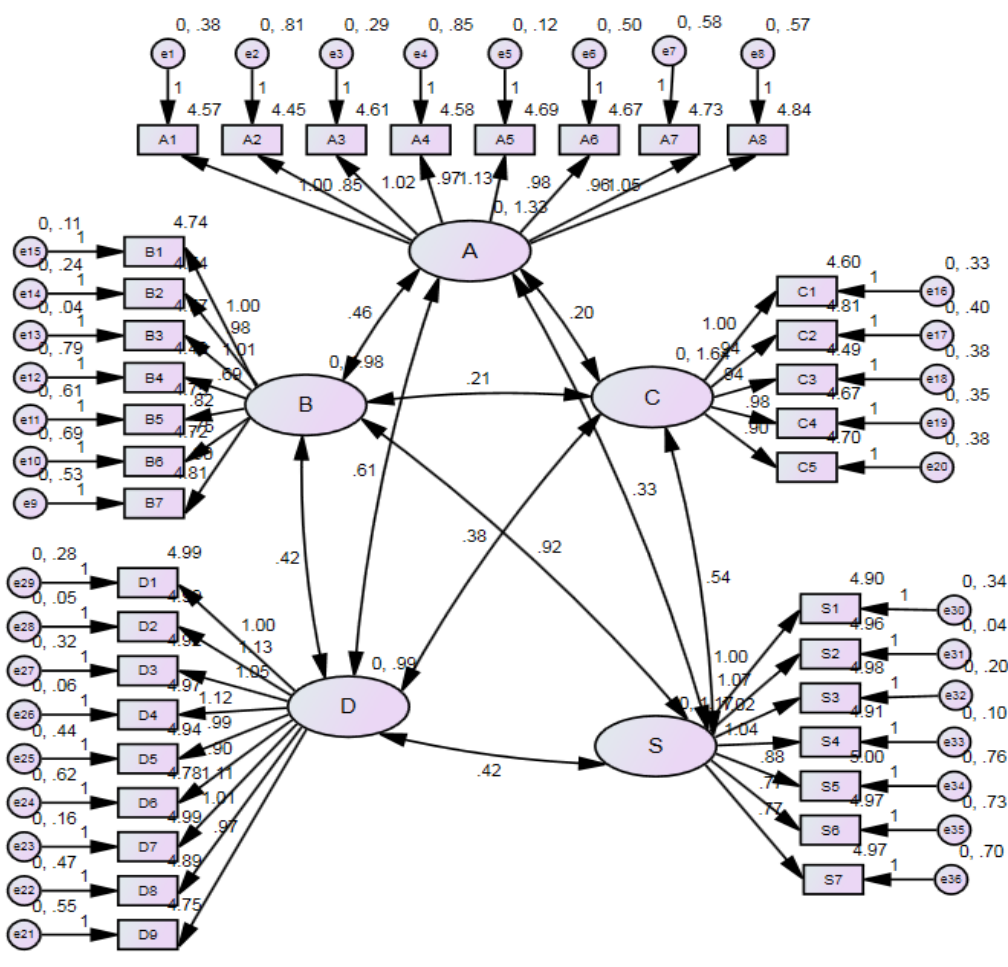
Figure 2. Path diagram from the CFA.